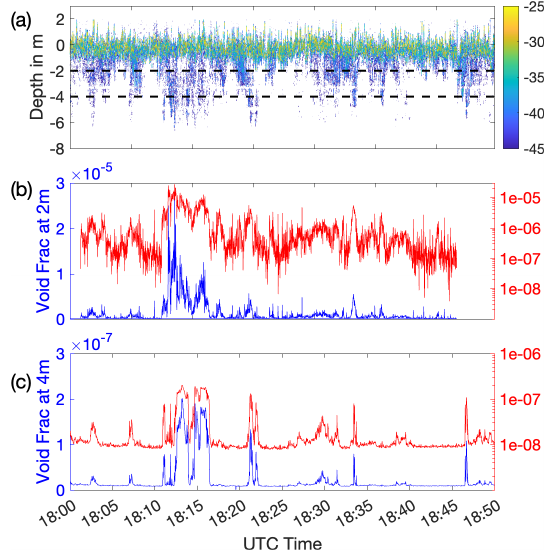
Figure 3. Comparison of simultaneous measurements from (a) the upward-looking sonar, (b) the bubble camera at 2m depth, and (c) the resonator at 4m depth. These plots cover one 45min mea- surement period of the bubble camera, on 2 November from 18:05– 18:50. The wind speed was 18ms − 1 . Panel (a) shows backscatter cross section per unit volume in decibels from a vertical 10 ◦ section of the arc; the dotted lines show the vertical position of the camera and resonator. To make the comparison between instruments clear, the sonar data are shown relative to the equilibrium water surface position on the buoy, not adjusted to instantaneous depth as waves pass. Panels (b) and (c) show void fraction for camera and resonator respectively, on a linear scale on left, and a log scale on right. Note that the y -axis scales for camera and resonator differ by 2 orders of magnitude. There is good agreement in the features observed be- tween all three instruments.